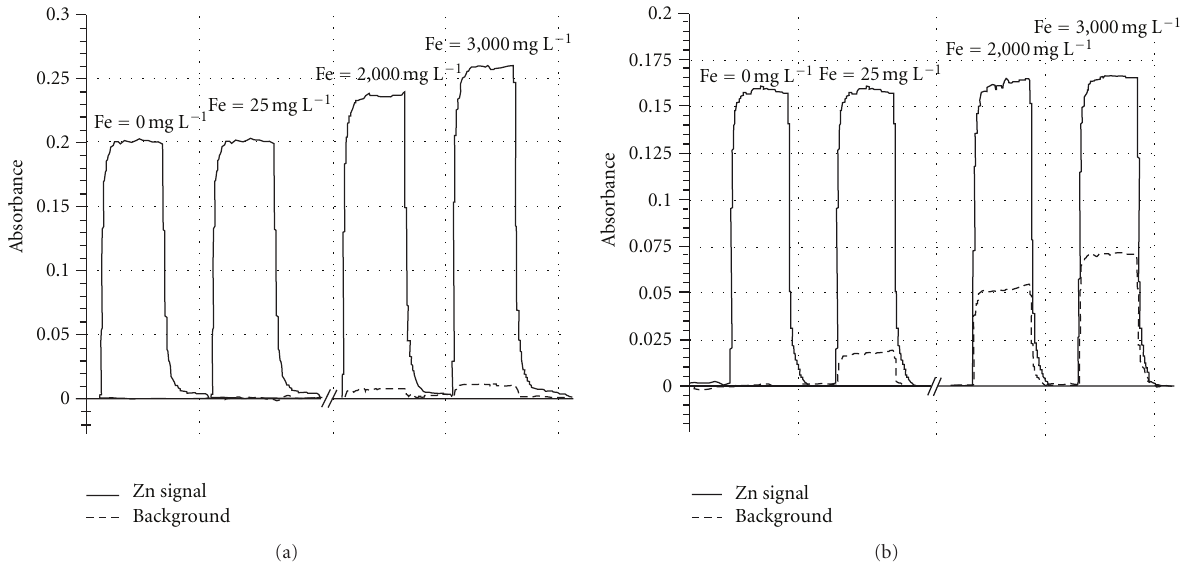
Figure 3: E ff ect of Fe in water on the signal of Zn at 0.5mg L − 1 using (a) deuterium background correction (D 2 method) (b) high-speed self-reversal background correction (HSSR